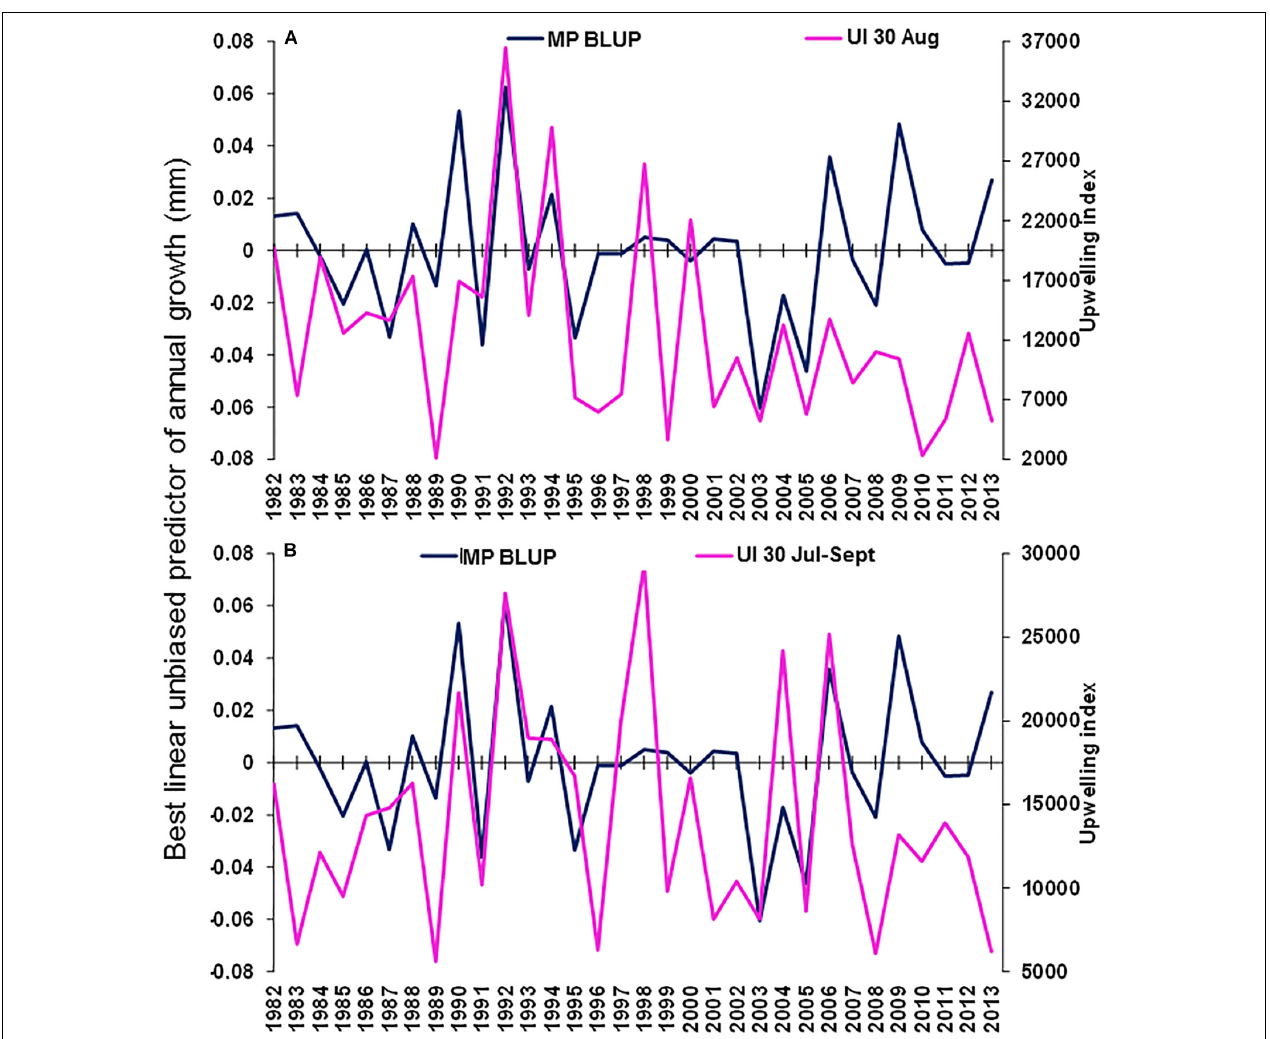
FIGURE 7 | Merluccius paradoxus (MP) caught in Namibia best linear unbiased predictor (BLUP) of annual growth from otolith increments (blue) and the (A) August and (B) August–October mean upwelling index (UI) along the coast for the southern Benguela at –30.0 latitude (30)